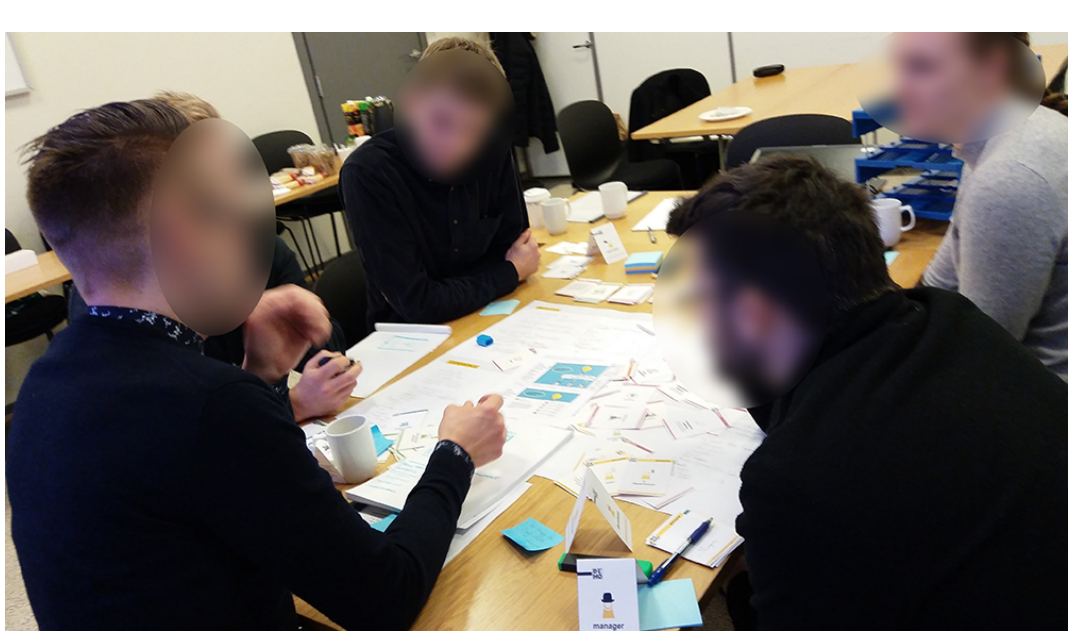
Figure 3. Participants working on the design task during the